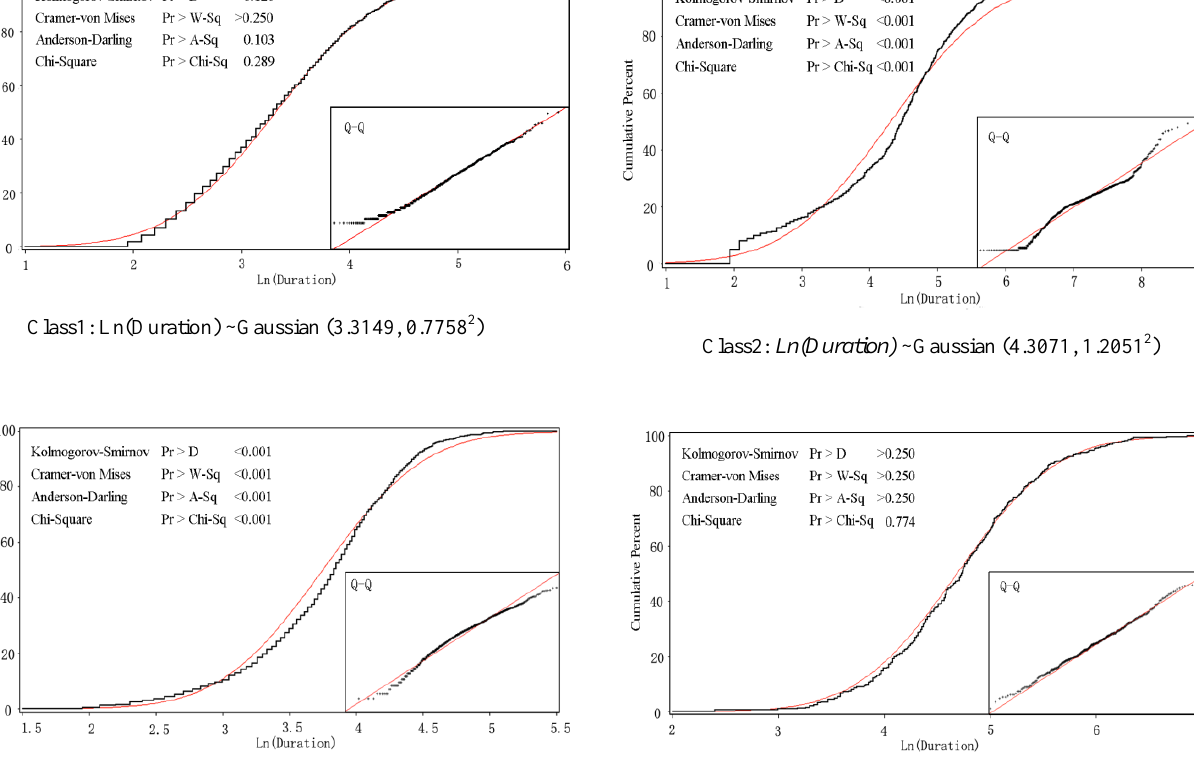
Fig. 5. Distributions fit test of